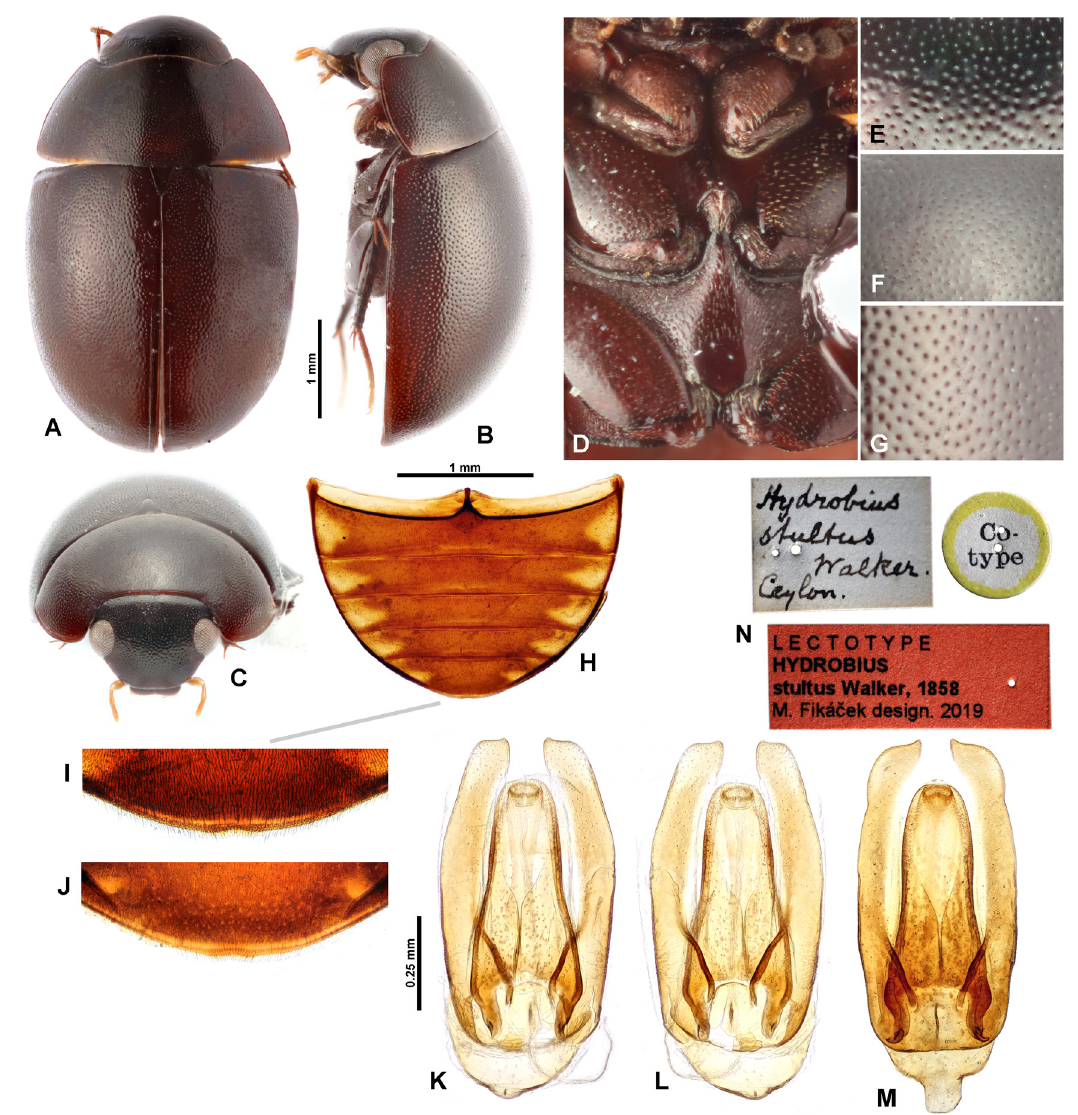
Fig. 10. Coelostoma ( Holocoelostoma ) stultum (Walker, 1858) . A . Dorsal habitus. B . Lateral habitus. C . Head. D . Thorax in ventral view. E . Dorsal punctation of head. F . Dorsal punctation of pronotum. G . Dorsal punctation of elytron. H . Abdominal ventrites. I–J . Detail of abdominal apex. K–M . Aedeagus: dorsal (K) and ventral (L–M). N . Labels of the lectotype. Specimens: A–I, K–L. Non-type specimens from Uttar Pradesh, Fatehpur Sikri, ♂ (NMPC). J, N. Lectotype, ♀ (BMNH). M. Non-type specimen, ♂, from Sri Lanka: Colombo